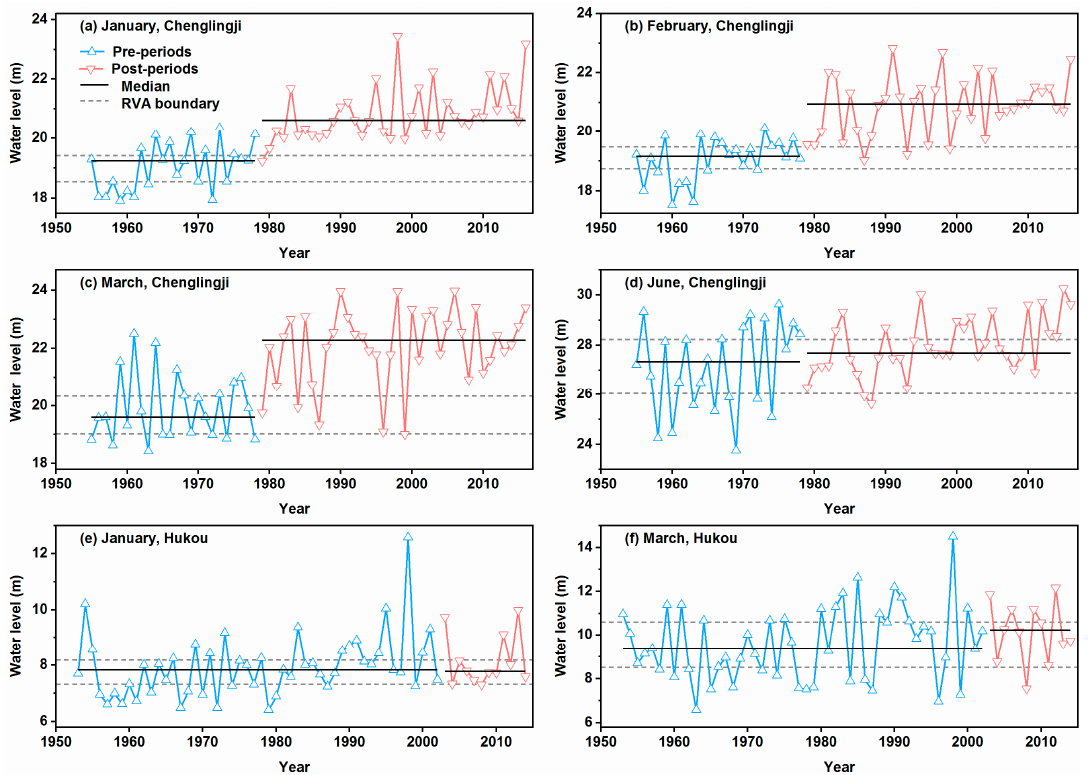
Figure 2. Variations in the highly and severely altered monthly water level at Chenglingji and Hukou. ( a ) January water level at Chenglingji, ( b ) February water level at Chenglingji, ( c ) March water level at Chenglingji, ( d ) June water level at Chenglingji, ( e ) January water level at Hukou, ( f ) March water level at Hukou.